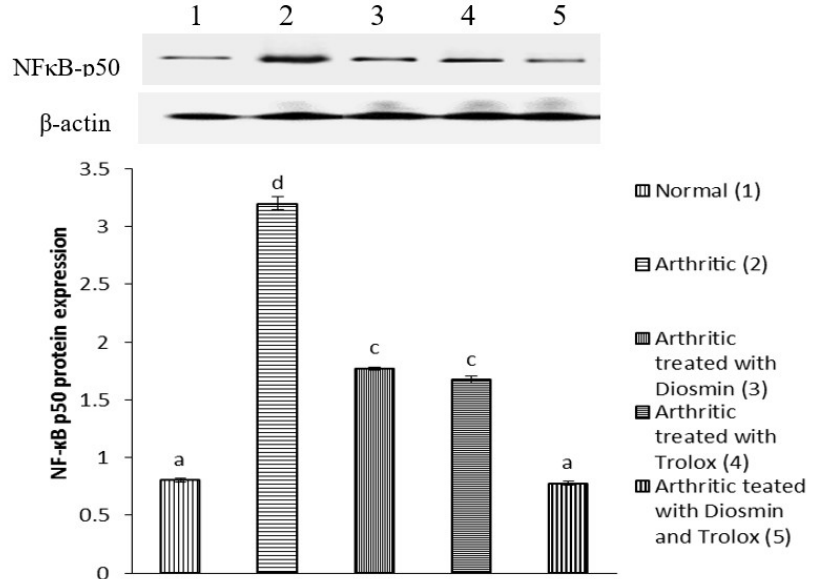
Figure 4. Effect of diosmin, trolox and their combination on NF-κB p50 protein expression level in CFA-induced arthritic rats. Means that have the same symbols (s) are not significantly different ( n = 3).